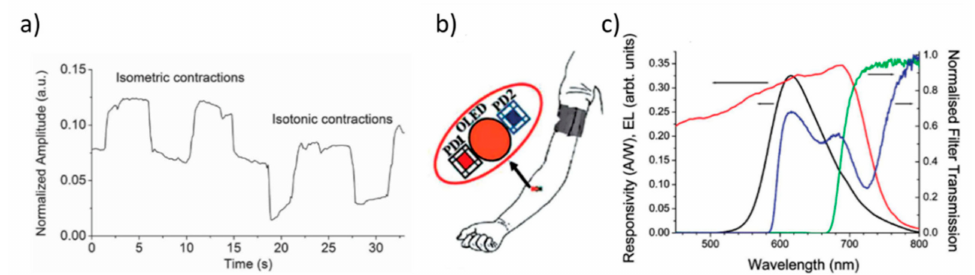
Figure 11. Response to isometric and isotonic muscle contractions reported by the wearable muscle contraction sensor based on the integration of one OLED and four OPDs ( a ). Representation of the bendable blood oxygenation sensor ( b ) and the corresponding electroluminescence (EL) spectra (left axis) of OC 1 C 10 -PPV-based OLED (black line), responsivity of PTB7 / PC 70 BM photodiode (red line) together with their filter transmissions (right axis), i.e., 610 nm (blue line) and 700 nm (green line) ( c ). Adapted with permission from [67], © 2020 WILEY-VCH Verlag GmbH & Co. KGaA, Weinheim.